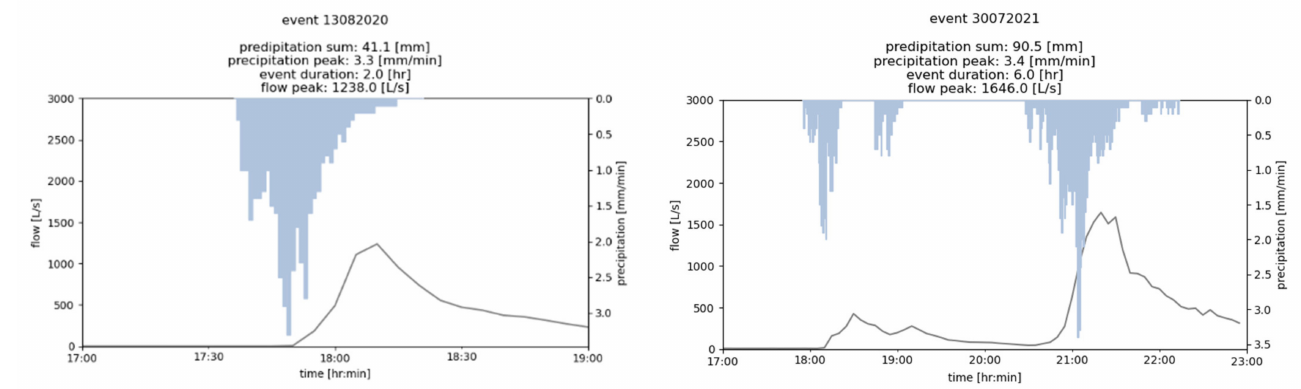
Figure 3. Extreme storm events in the Annabach catchment including flow in the Annabach stream used for calibration ( left side ) and identification of the most impact uncertainty source ( right side ).